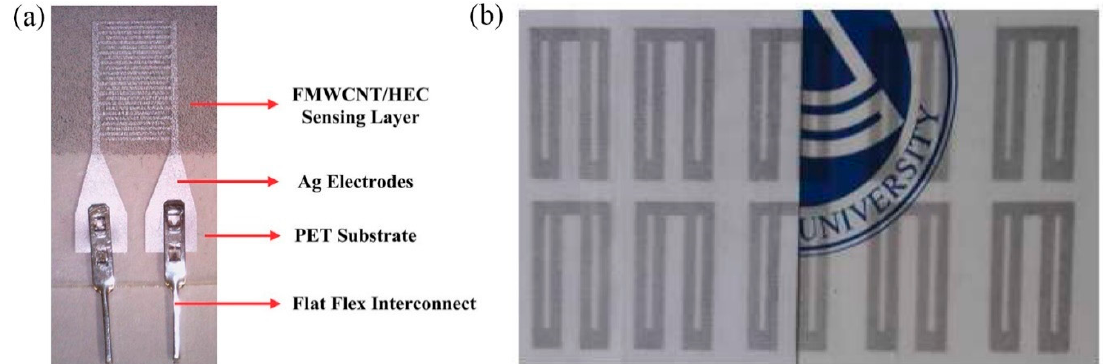
Figure 7. ( a ) FMWCNT/HEC on Ag electrodes (reproduced with permission from [21] copyright 2019, The Royal Society of Chemistry); ( b ) high-transparent PEDOT/rGO/PEI-Au NP printed geometry with good mechanical endurance (reproduced with permission from [22] copyright 2018, Elsevier).